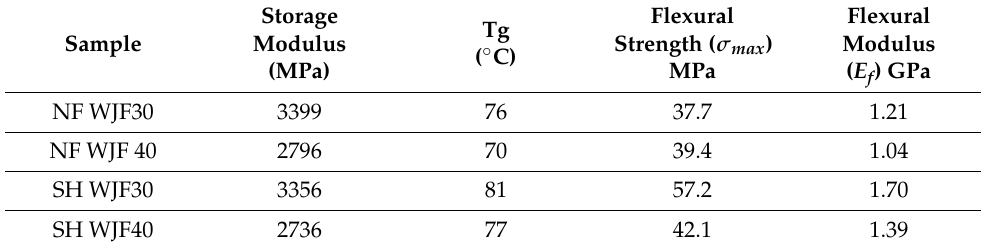
Table 3. Summary of viscoelastic and flexural properties of the obtained